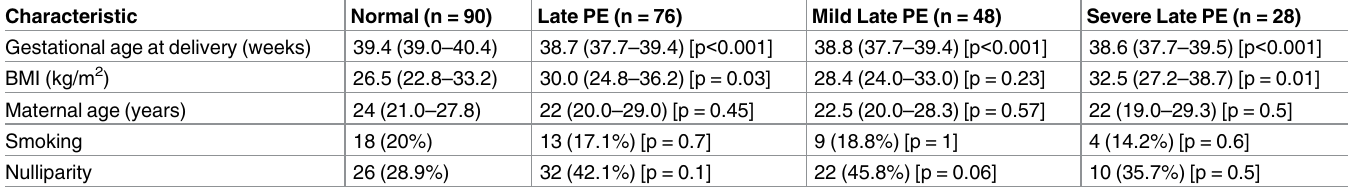
Table 1. Demographic characteristics of the study population.